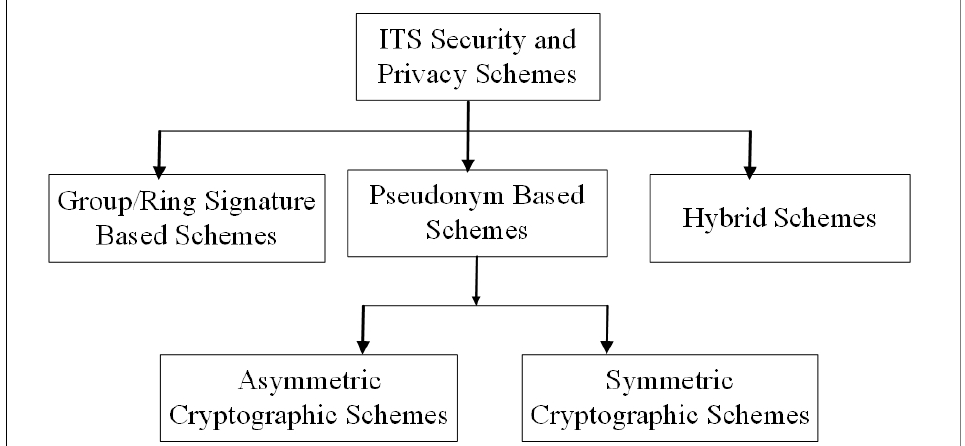
Figure 6. ITS security and privacy schemes categorization.